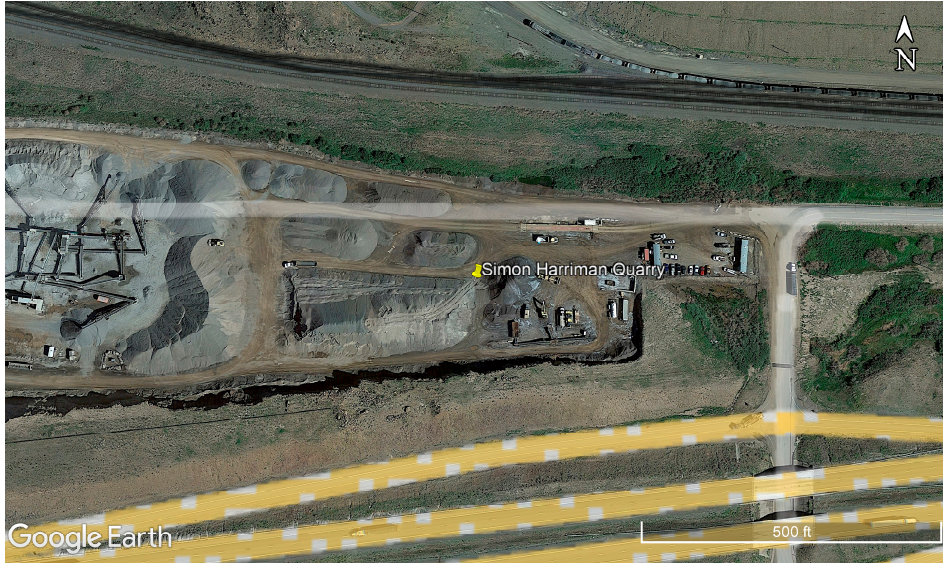
Figure 4. Location of the quarry site (Imagery ©2023 CNES/Airbus, Maxar Technologies, Map data ©2023 Google, reproduced with permission from Google, 2023).